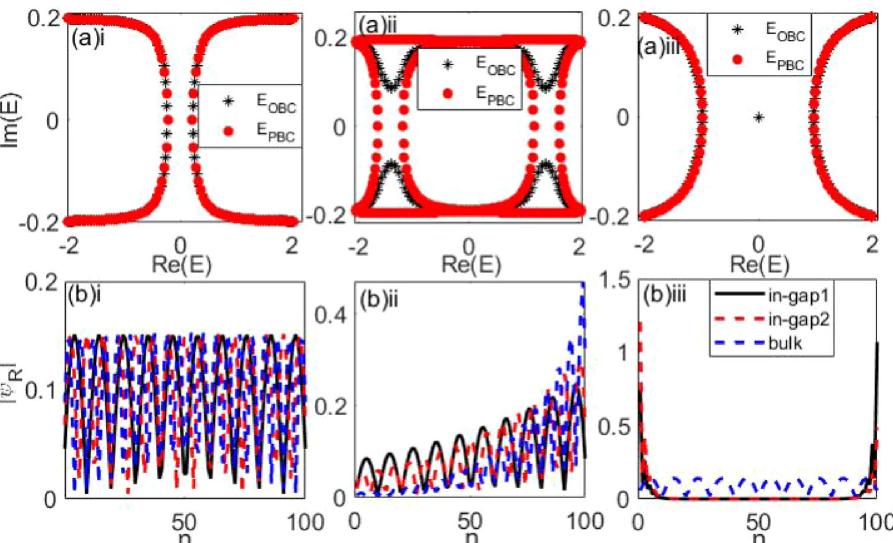
Fig. 2 Non-Hermitian skin effect and band topology for cases I and II. Eigen-spectrum ( a (i – iii)) and spatial pro fi le of eigen-modes ( b (i – iii)) for case-I and -II when only one spin-orbit coupling (SOC) is present. Here we take the dissipation strength γ = 0.2, and the other parameters are ( Ω 0 , ϕ 0 , Ω r , ϕ r ) = (0, − , 0.3, π ) for a (i), b (i); (0, − , 0.3, π /2) for ((a)ii,(b)ii); (0.5, π /2, 0, − ) for a (iii), b (iii). The non-Hermitian skin effect shows up only in a (ii), b (ii). a (iii), b (iii) are topological with two in-gap zero modes localized at both boundaries. Here the energy unit is taken as hopping t .